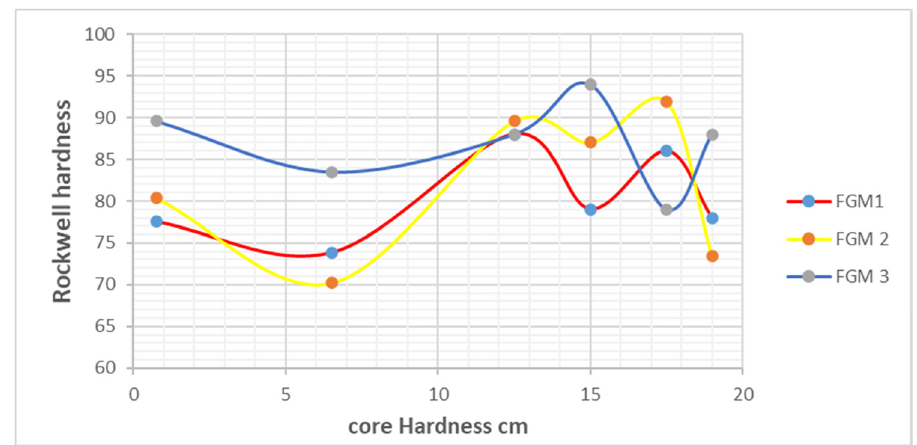
Figure 15: Core hardness.